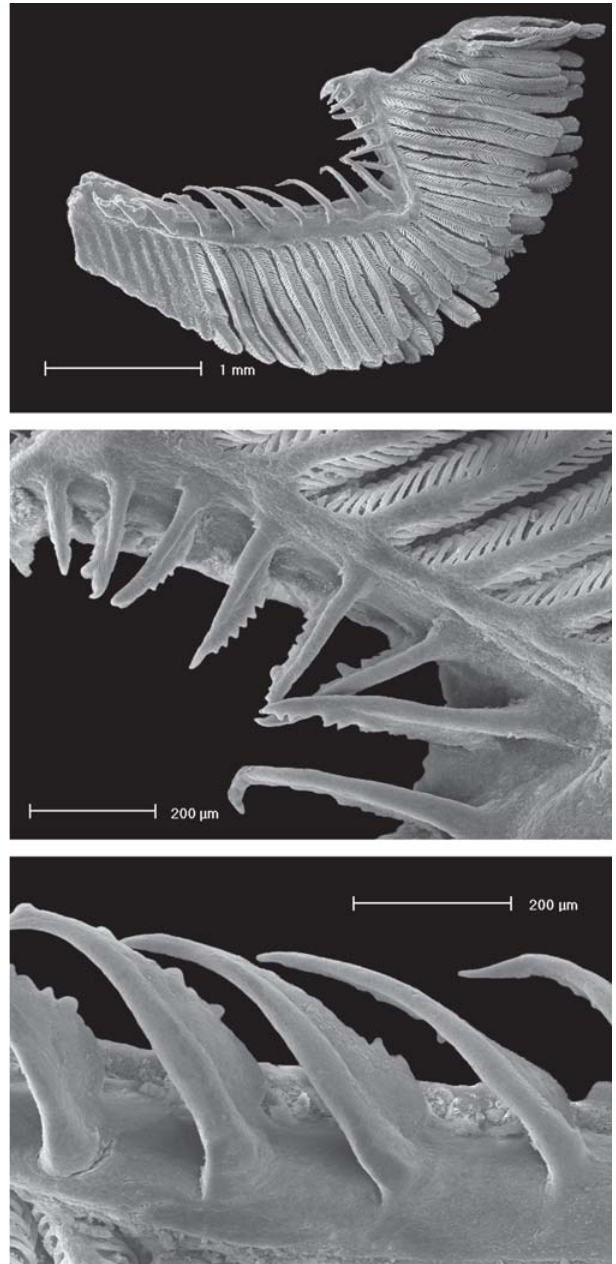
Fig. 25. First gill arch of Odontostilbe pao , MCNG 54107, male 28.8 mm SL. SEM photographs of the first gill arch, left side, lateral view, showing gill gland (top), in detail gill rakers on upper branchial branch (middle), and gill rakers on lower branchial branch